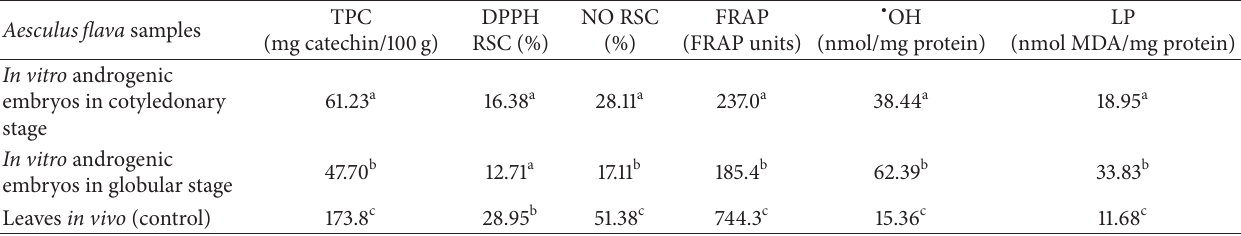
Table 1: Total phenolic content, DPPH and NO RSC, FRAP, ∙ OH quantity, and lipid peroxidation in A. flava . Aesculusflava samples In vitro androgenic embryos in cotyledonary stage In vitro androgenic embryos in globular